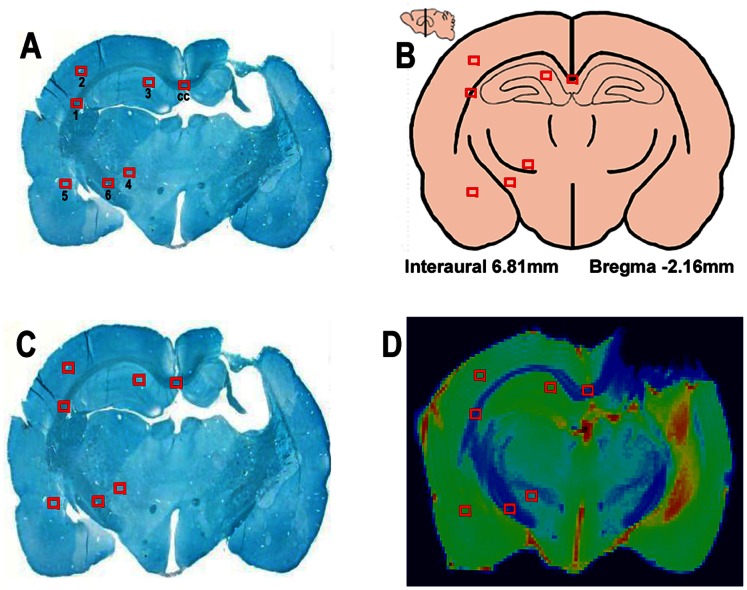
Locations of selected ROIs in original Bielshowski Luxol Fast Blue staining section (A), anatomic brain structures (B) [31], warped staining section (C) to T2 weighted image and corresponding warped ROIs in the T2 weighted image (D).